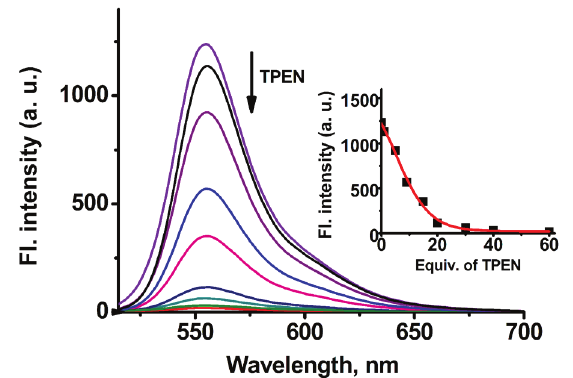
Figure 4 : Fluorescence titration spectra of a solution of sensor Rh6G-1 (10 μM) + Fe 3+ (10 equiv.) with TPEN (0 - 60 equiv.) in water (containing 1% DMSO as a cosolvent). Inset: Fluorescent intensity at 556 nm of a solution of sensor Rh6G-1 (10 μM) + Fe 3+ (10 equiv.) upon addition of TPEN (0 - 60 equiv.). Excitation at 500